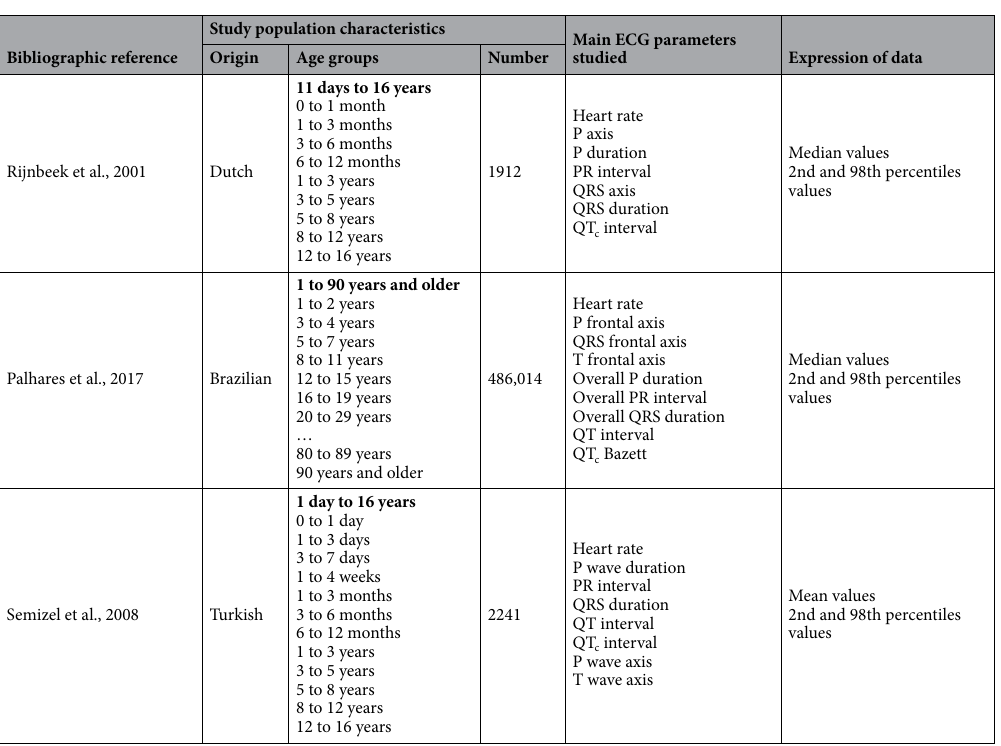
Table 3. Main features of studies identified for the comparative analysis of ECG